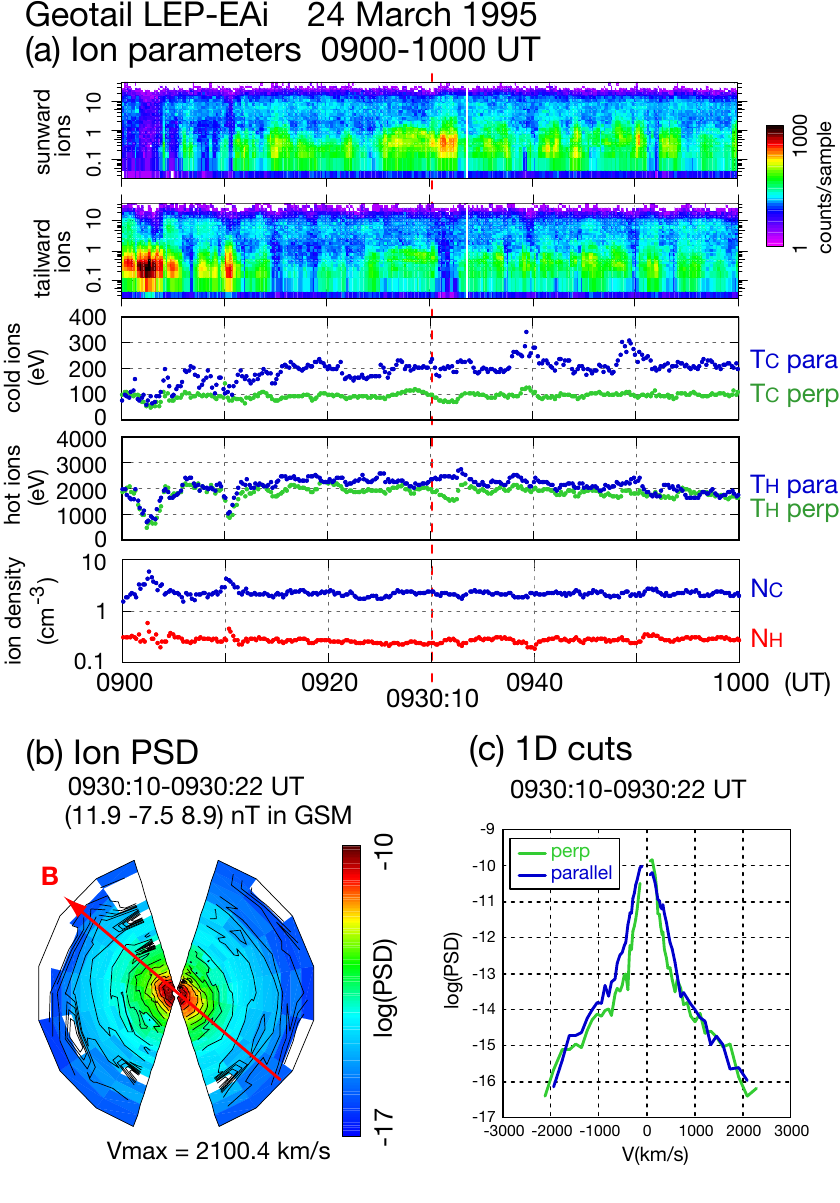
Fig. 2. The upper panel (a) shows Geotail observations between 09:00–10:00 UT on 24 March 1995. From the top, energy-time (E-t) diagrams of sunward and tailward ions, temperatures and densities of cold and hot components of protons are shown. The perpendicular (parallel) temperature is shown by the green (blue) points, the density of the cold (hot) component is shown by the blue (red) points. The lower left panel (b) shows a cut of ion PSD for the 12-s interval 09:30:10–09:30:22 UT in the plane that includes the magnetic field. The field direction is shown by the red arrow. The lower right panel (c) shows one-dimensional cuts of the PSD in the direction perpendicular (green curve) and parallel (blue curve) to the local magnetic field.